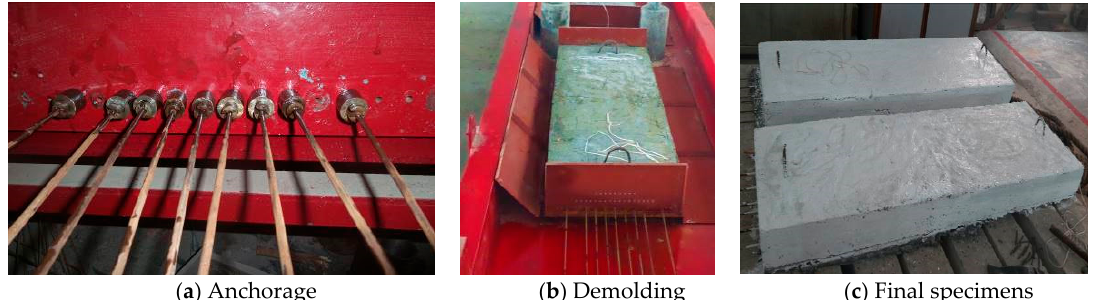
Figure 1. Preparation of high strength concrete (HSC)/high strength fiber-reinforced concrete (HSFRC) prestressed deck panels.